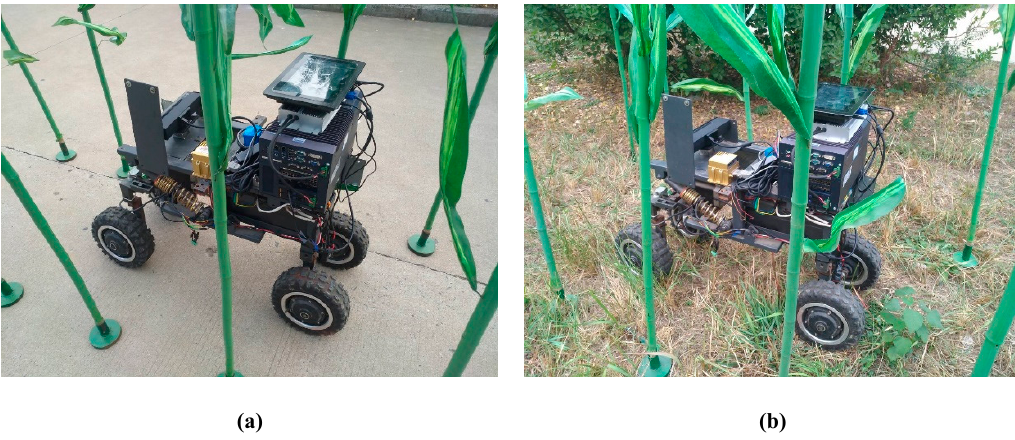
Figure 17. Artificial simulation environment. (a) Artificial simulation of road environment; (b) Artificial simulation of field environment.